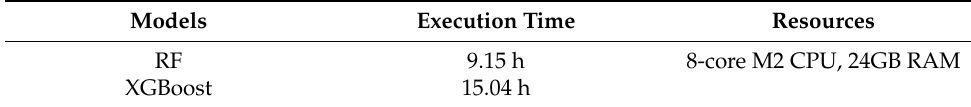
Figure 6. HPO of RF and XGBoost model . Table 2. Execution time of models and